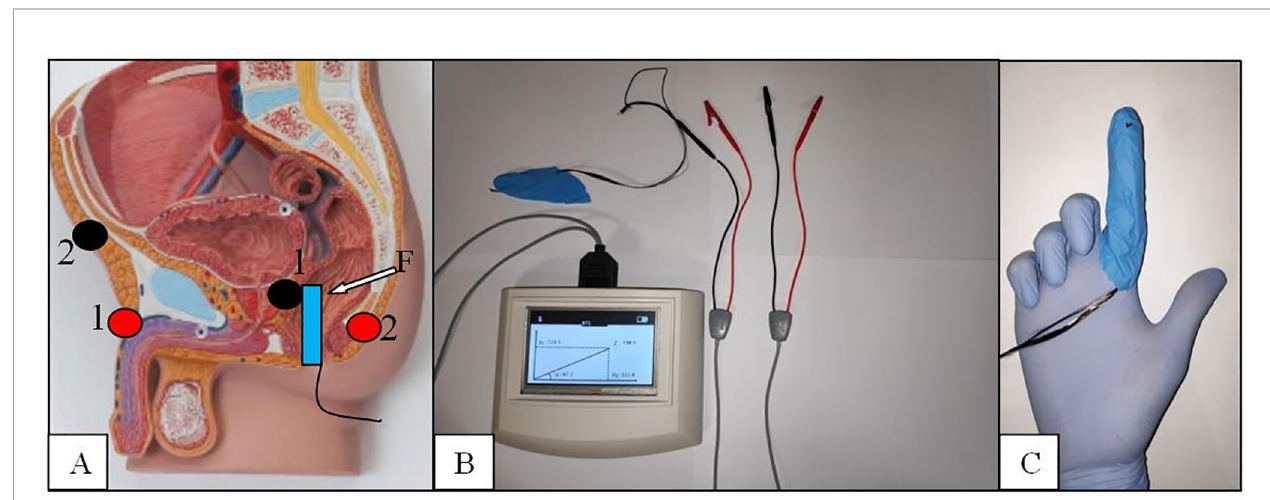
FIGURE 2 | The BIA endorectal probe. (A) Electrodes placement red/black 1:1 and 2:2. (B) The BIA tester. (C) The fi nger probe with the carbon fi bers placed at the tip of the second fi